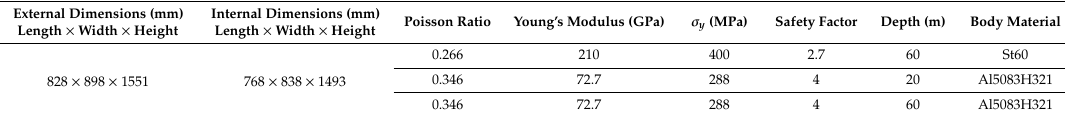
Figure 3. Contours of von Misses stress for various compartments: ( a ) steel compartment, ( b ) aluminum compartment (depth of 20 m), and ( c ) aluminum compartment (depth of 60 m).